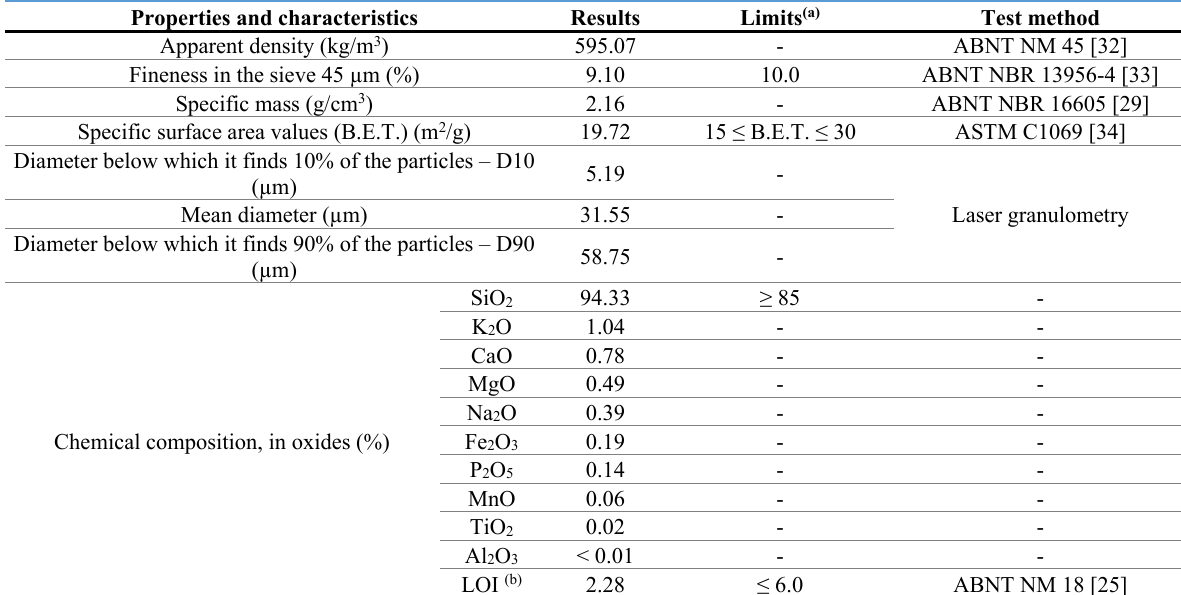
Table 3. Physical and chemical properties of the silica